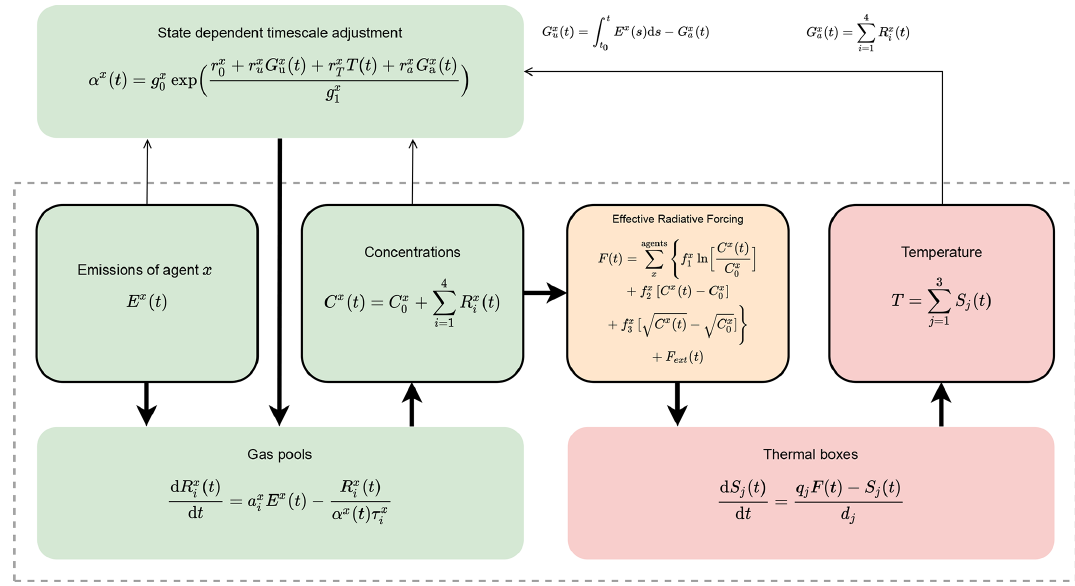
Figure 1. Schematic showing the full model structure and equations used. Terms without (t) are constants. Colouring splits the model into gas cycle, radiative forcing, and climate response components. The dashed grey line indicates the components identical to AR5-IR (Myhre et al., 2013). Table 1 provides brief descriptions of each named parameter in the figure. We note that under the default parameterization, for all gases except carbon dioxide, the index i and associated sums can be removed as these gases are modelled as having a single atmospheric decay timescale only. Equations are described in full in Sect.